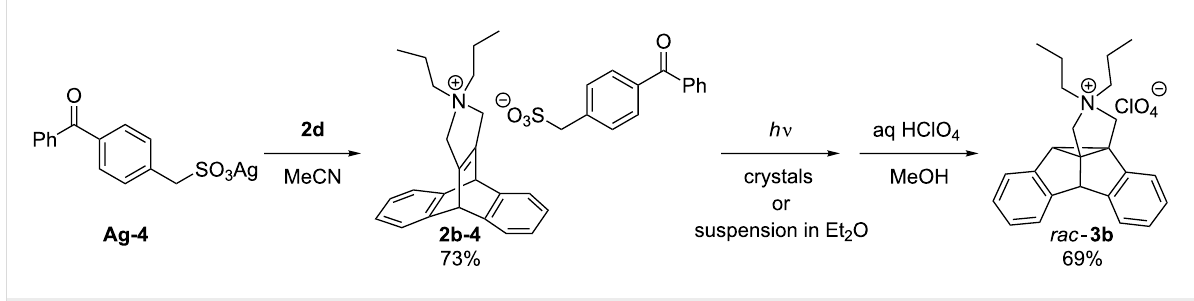
Irradiation of ground crystals of the salt 2b-4 for 2 h induced a DPM rearrangement to the dibenzosemibullvalene derivative 3b